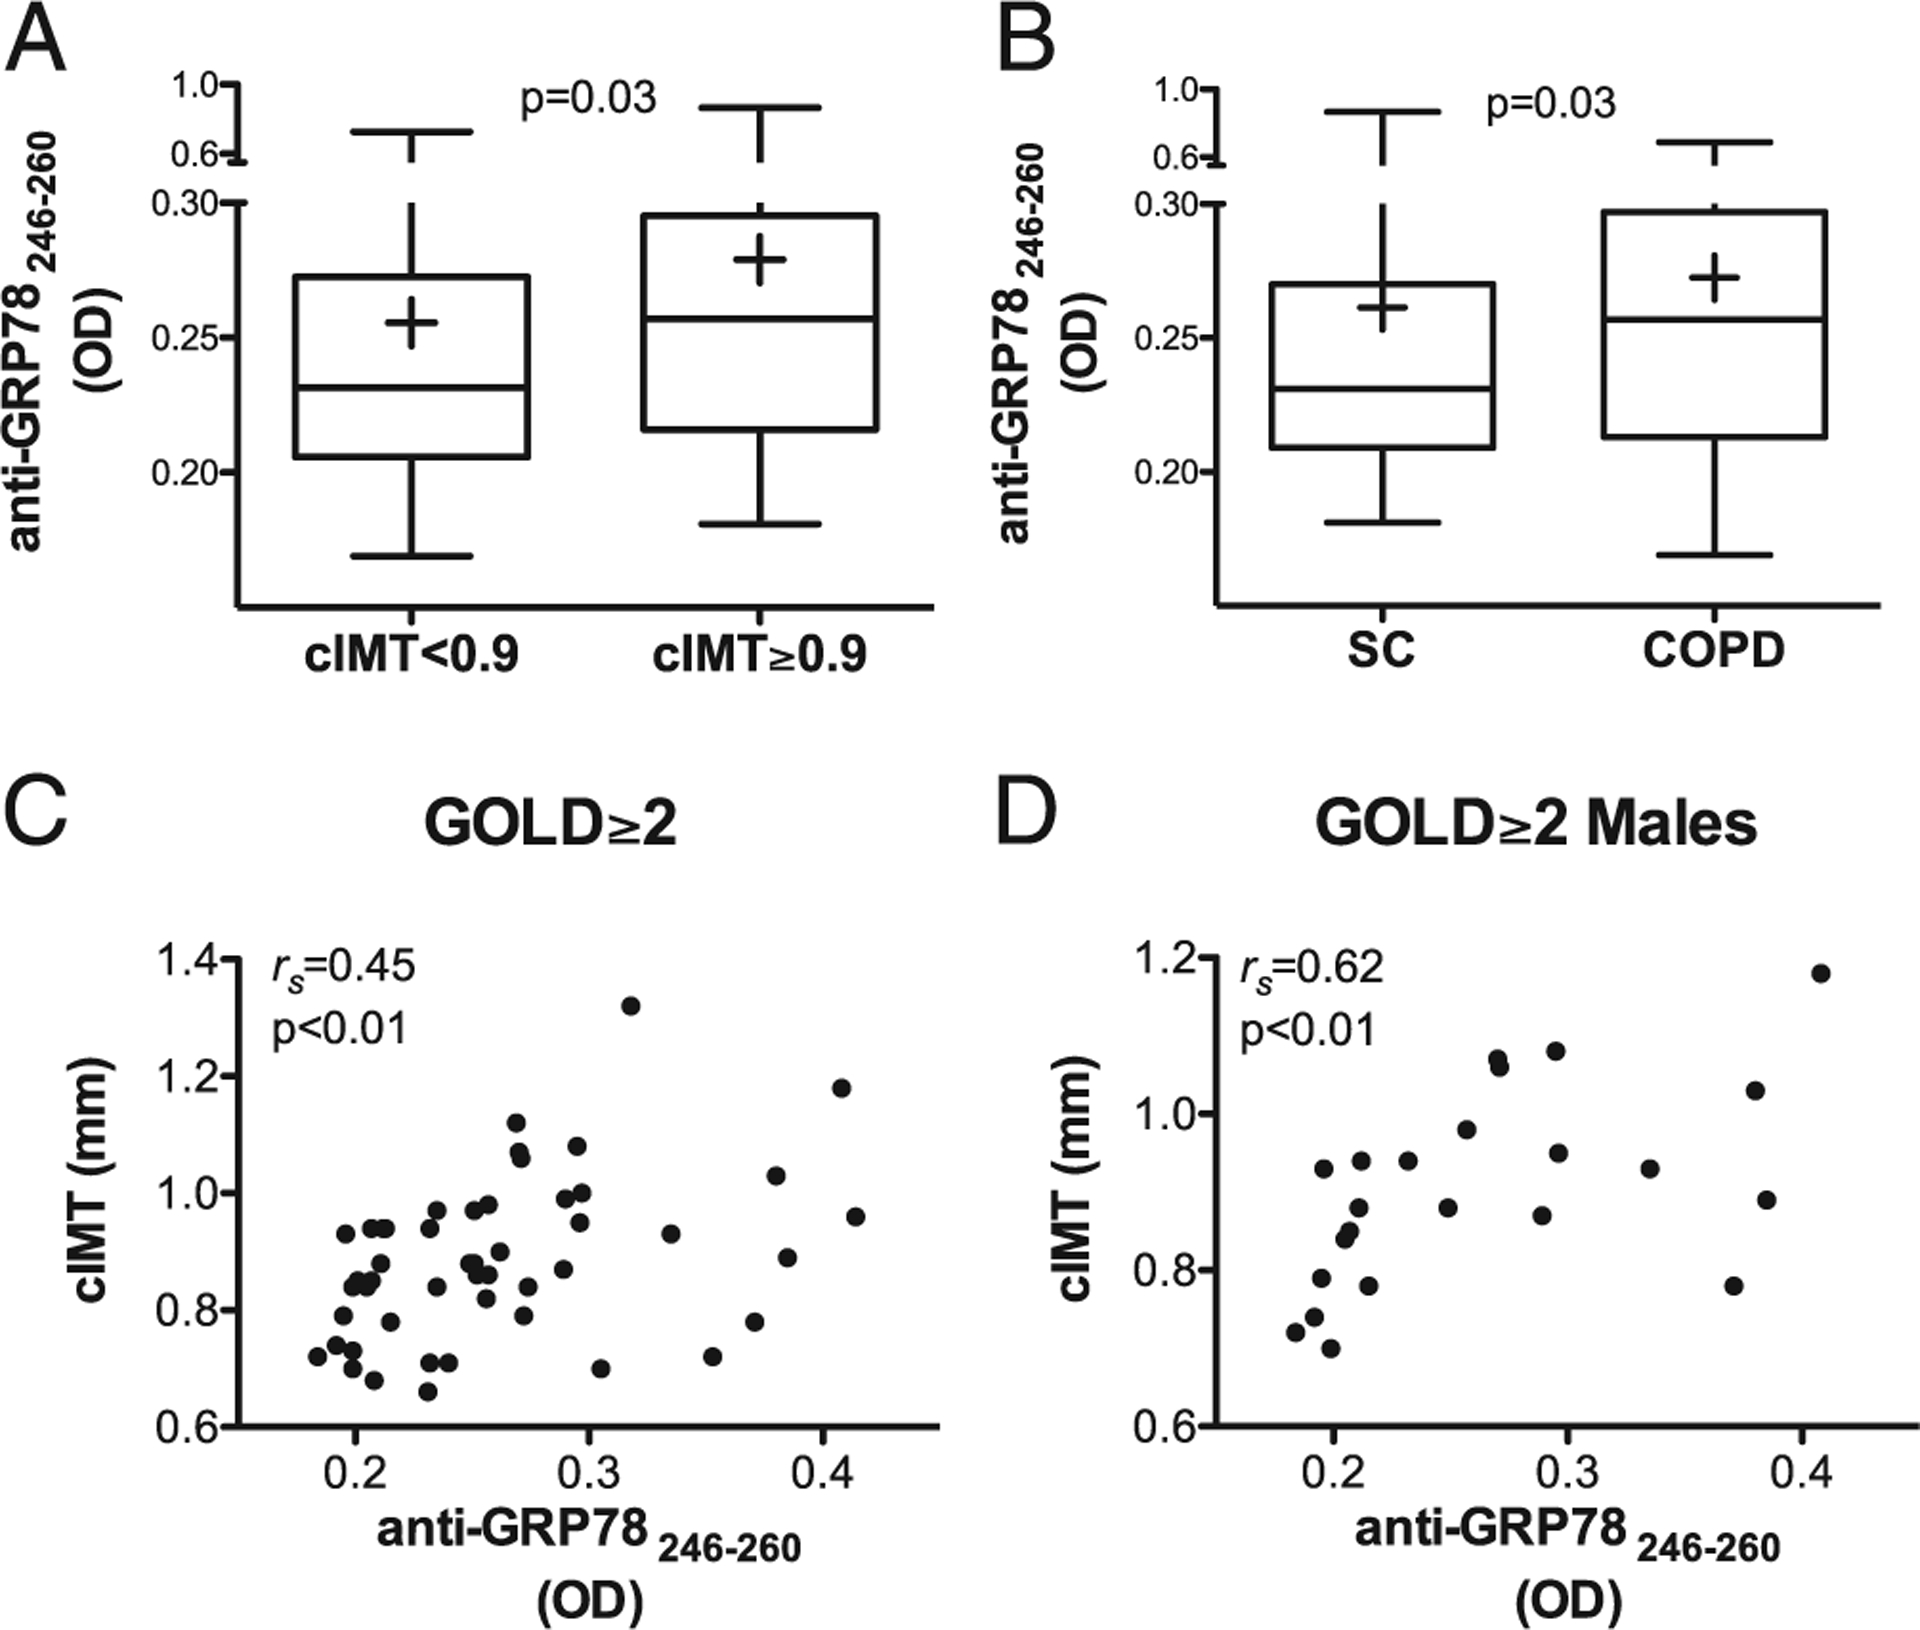
Autoantibodies to GRP78aa 246–260 peptide were even more related to measures of carotid artery disease.(A) Circulating IgG autoantibodies to GRP78aa 246–260 peptide (as OD measured by ELISA) were higher in the population with abnormal cIMT (≥0.9 mm), compared with those with normal cIMT. The lowest, second lowest, middle, second highest, and highest lines represent the 10th, 25th, median, 75th, and 90th percentiles, respectively. Means are denoted by the plus sign (+). (B) Anti-GRP78aa 246–260 autoantibodies were increased in COPD patients compared with SC. (C) Correlation between levels of anti-GRP78aa 246–260 autoantibodies and cIMT among patients with moderate to advanced COPD (GOLD ≥2) (24). (D) Correlation between anti-GRP78aa 246–260 autoantibodies and cIMT among males with COPD GOLD ≥2.